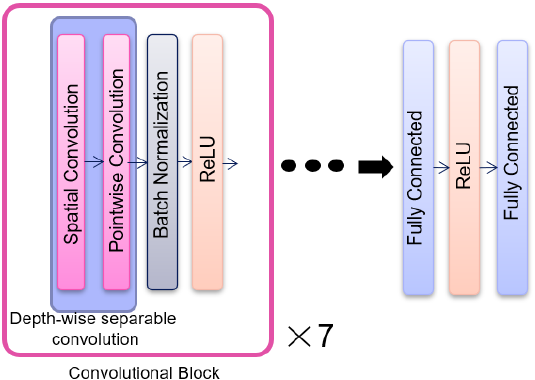
Figure 6. The MGMTClassifier architecture consisting of seven convolutional blocks with depth-wise separable convolutions spaced by batch normalization and ReLU as activation function, followed by two fully connected layers and a ReLU